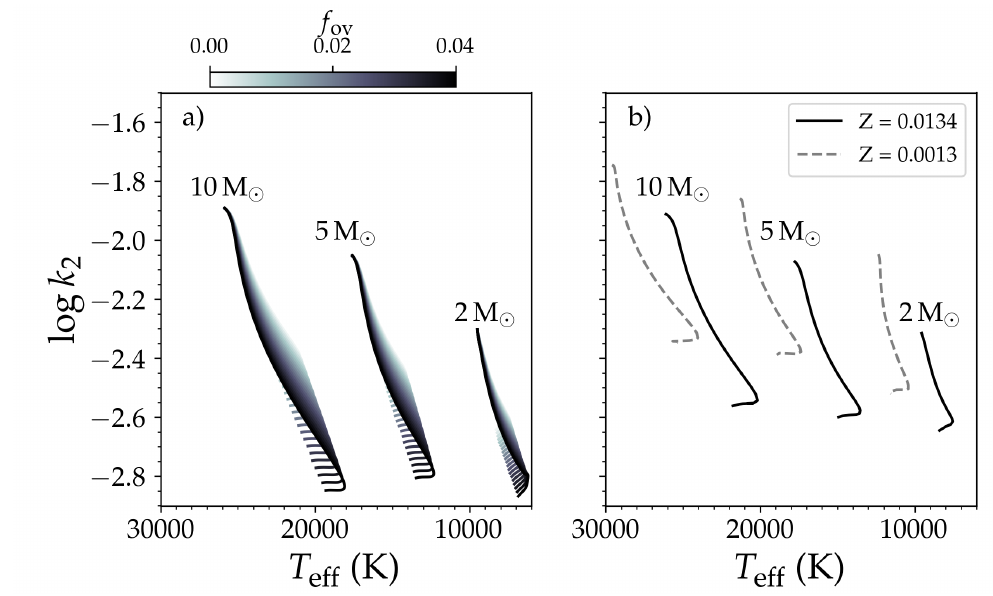
Figure 9. Evolution of the apsidal constant k 2 for three different initial stellar masses. ( a ) Variation in k 2 resulting from varying the extent of the CBM region assuming exponential diffusive overshoot and a fixed initial chemical composition of X = 0.71, Y = 0.276, and Z = 0.014. ( b ) Variation in k 2 resulting from changing the initial metallicity of the stars, assuming a mass-dependent CBM [71]. Figure made by the authors using MESA models (panel a ) and pre-existing model grids by Claret [71] (panel b ). MESA inlists and data used to generate panel ( a ) are available on Zenodo